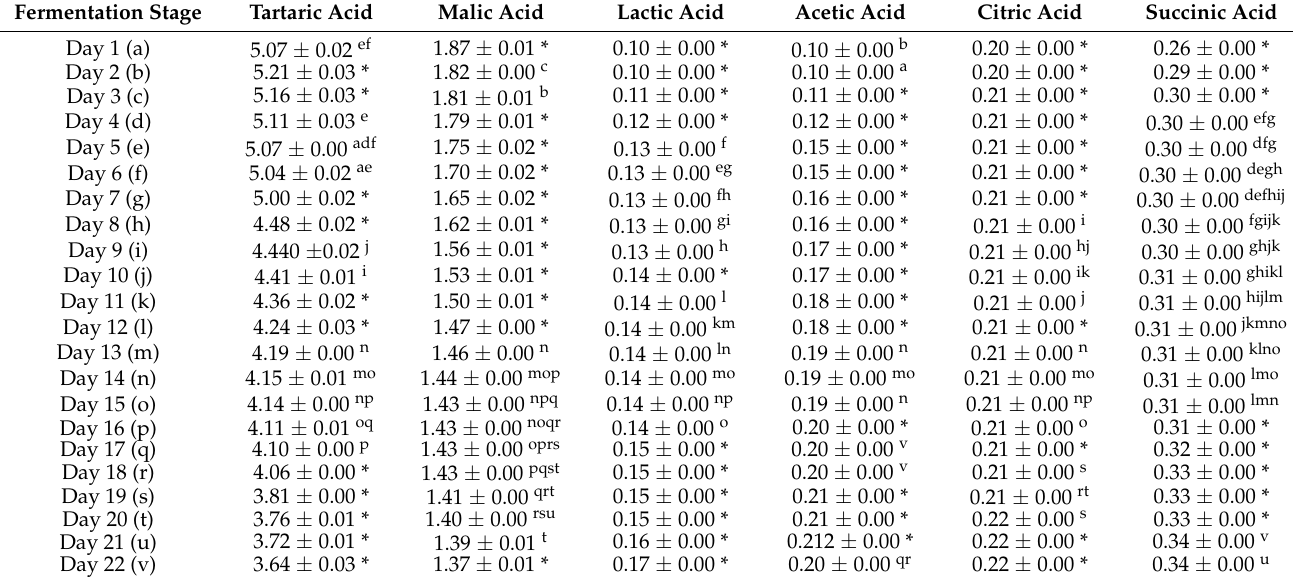
Table 6. Evolution of main organic acids during alcoholic fermentation of V5 variant (g/L). Fermentation